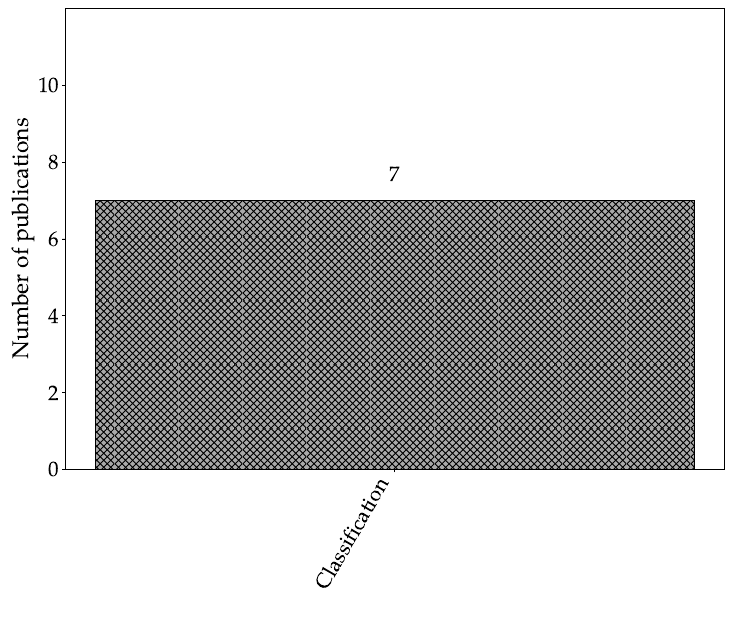
Figure 20. Repartition of SOM